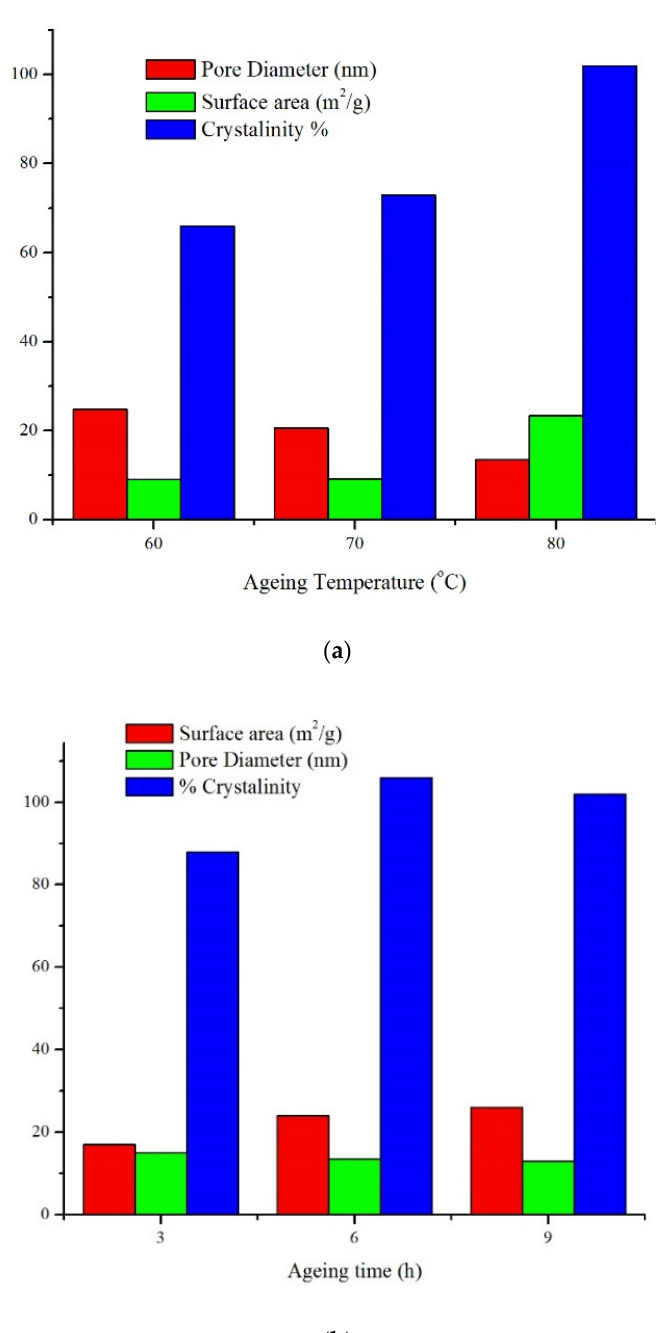
Figure 5. ( a ) and ( b ) Pore diameter and surface area of sodalite obtained at different temperatures but similar crystallization time—9 h.